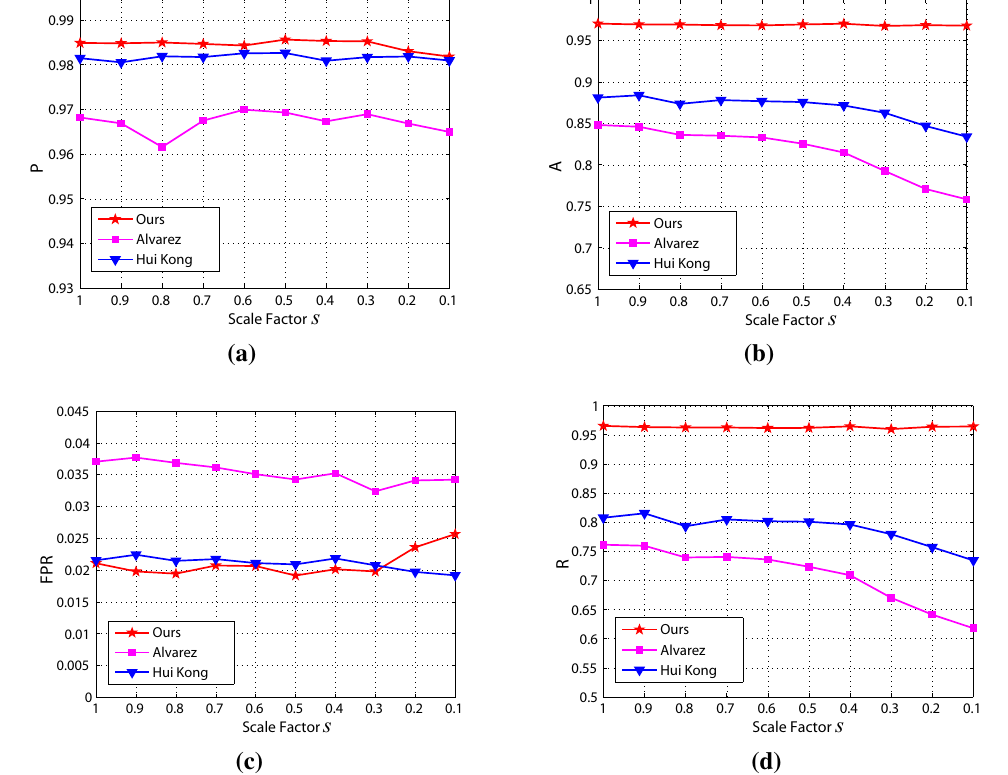
Figure 20. Results of the scale sensitivity evaluation: ( a ) precision; ( b ) accuracy; ( c ) false positive rate; ( d )